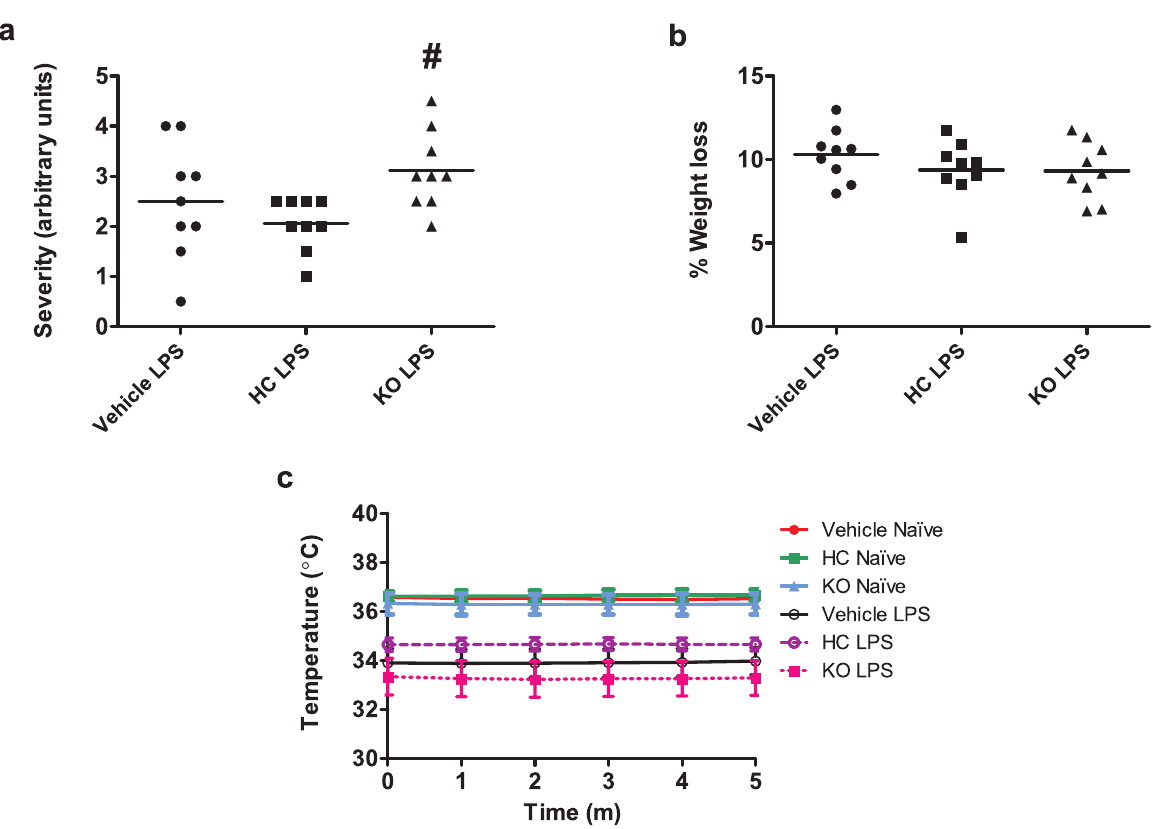
Figure 5. Clinical parameters in TRPV4 WT and KO mice. ( a ) Arbitrary severity score assigned in a blinded fashion after 24-h treatment with LPS (12.5 mg/kg, i.v.) based on voluntary mobility, gait, aversion to touch, facial expression and piloerection. WT mice were treated i.p. with vehicle (10% DMSO) or HC-067047 (HC) at the time of LPS administration. TRPV4 KO mice did not receive any pharmacological treatment. ( b ) Percentage weight loss over 24-h endotoxaemic period. Values for each animal are presented as individual symbols, with horizontal line denoting group mean. # p<0.05, relative to HC-treated animals, 1-way ANOVA + Bonferroni post-hoc test (n = 8–9). ( c ) Core temperature measured by rectal probe throughout blood flow recording period. Data are presented as mean ± SEM (n =